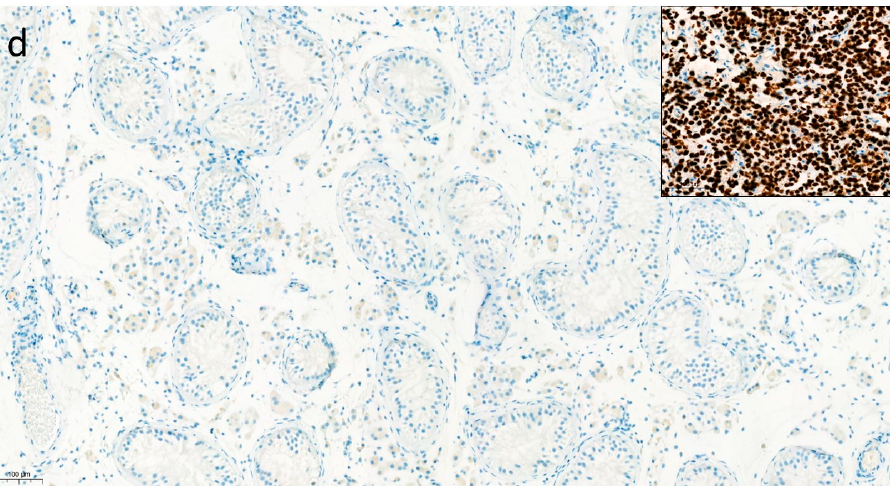
Figure 2. Histopathological analysis of testicular biopsy in subject IV-3. Seminiferous tubules with slight thickening and hyalinization of the basement membrane [( a ). hematoxylin and eosin staining, × 10, ( b ). trichrome staining, × 20]; Absence of germ cells on immunohistochemistry for PLAP (with positive placenta control sample in inset) ( c ) and SALL4 (with positive yolk sac tumor control in inset) ( d ).